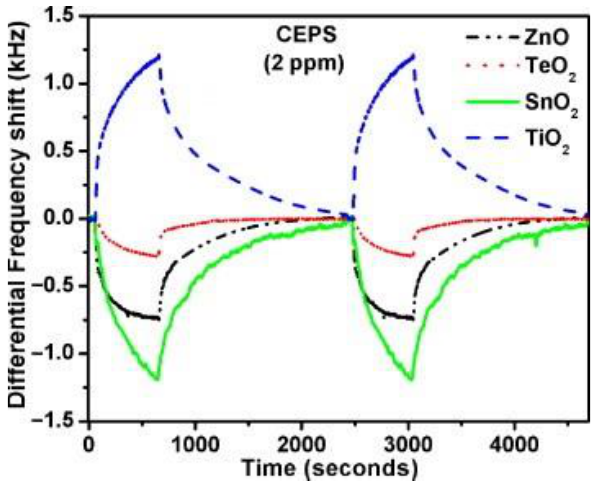
Figure 8. Real-time differential frequency shift ∆ F plots of four SAW sensors with oxide layers recorded during exposure to CEPS vapor [71]. ∆ F is defined as f 0 -f s (where f 0 , f s —frequency before and after exposure to analyte vapors). Reprinted with permission from [71]. Copyright 2013 Elsevier.